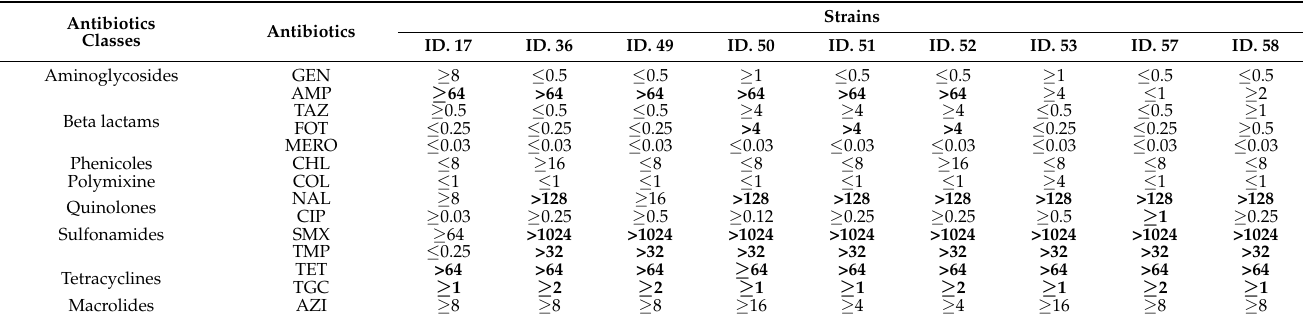
Table 2. MIC values ( µ g/mL) for MDR strains ( n =